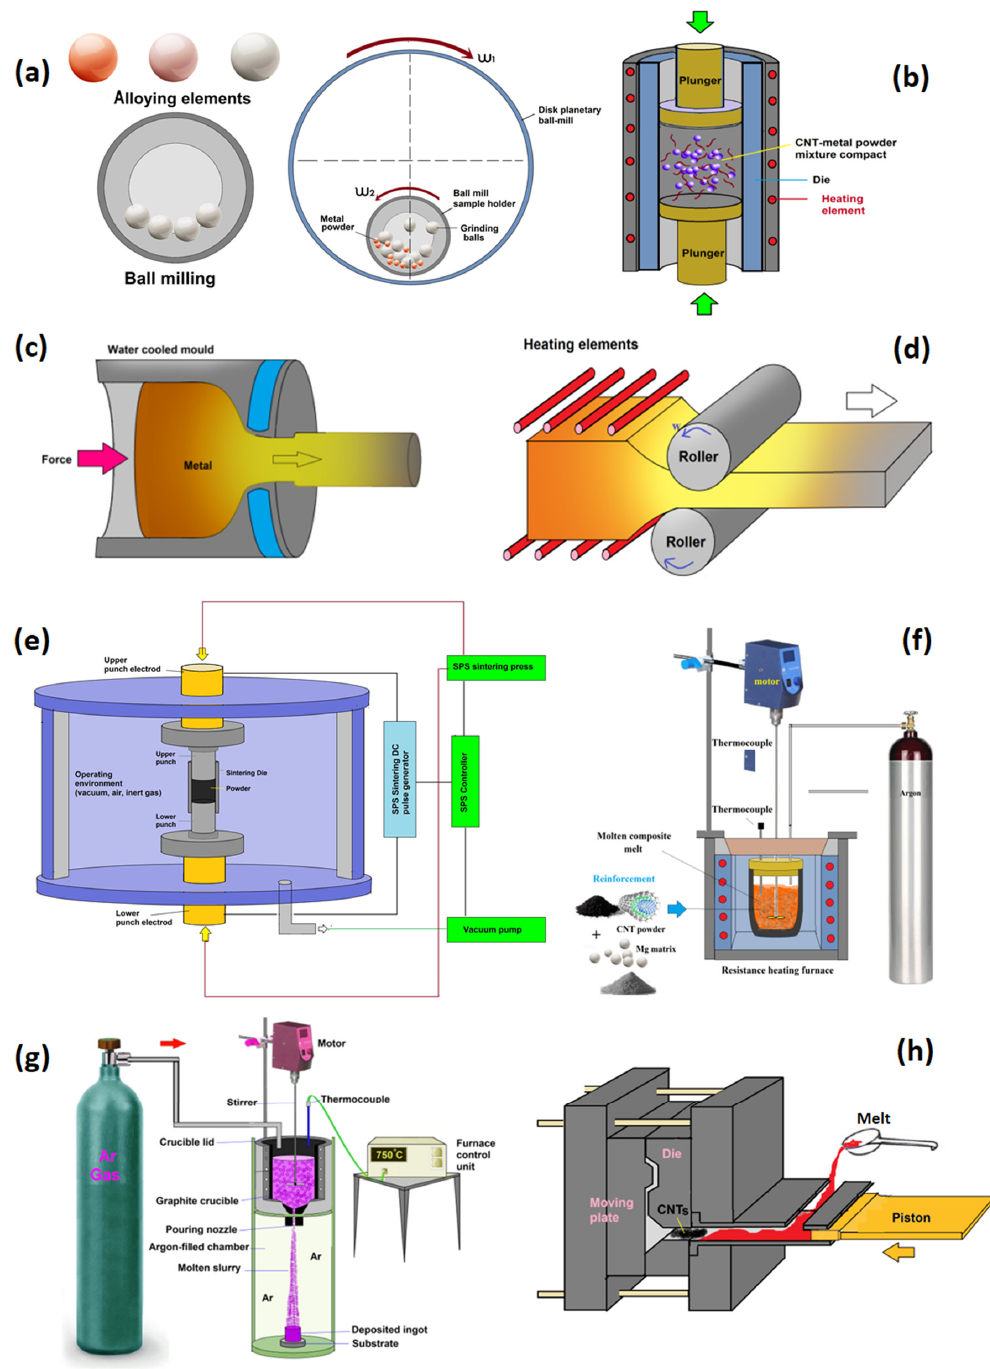
Figure 4. Different metallurgical methods for fabricating composites: ( a ) powder metallurgy [15], ( b ) hot press sintering, ( c ) hot-extrusion, ( d ) hot rolling, ( e ) spark-plasma sintering (SPS), ( f ) stir casting (SC), ( g ) disintegrated melt deposition (DMD) [11], and ( h ) high-pressure die casting [15].